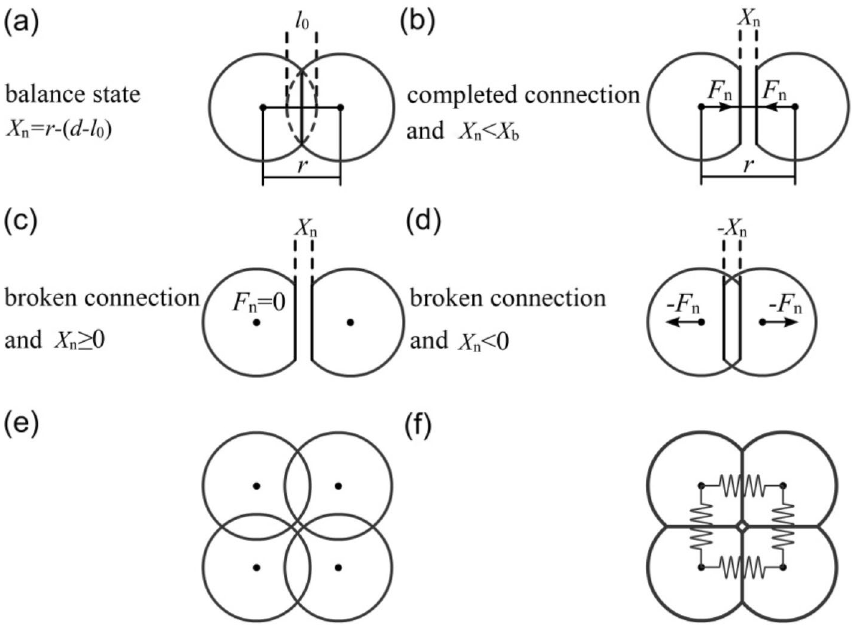
Figure 2. Schematic diagram of the elastic clump